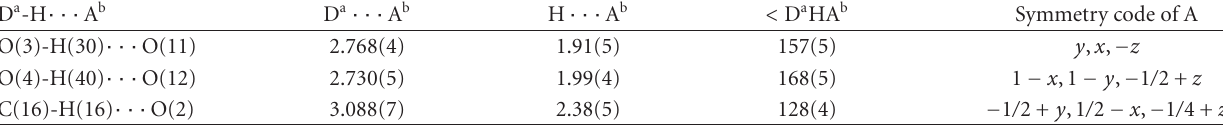
Table 3: Dimensions of the hydrogen bonds (distances in ˚A and angles in ◦ ) for complex 1 .